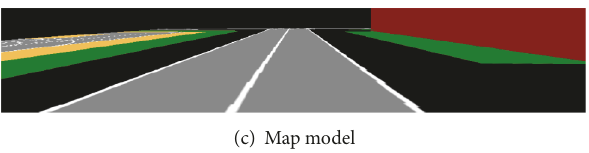
Figure 12: Example of a scene where the pixelwise classifier has a large number of false negatives and the use of a map-based model improves the